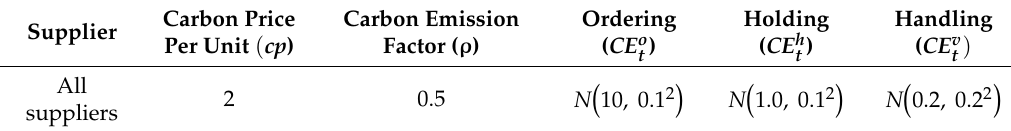
Table 5. Input parameters for carbon emissions cost.